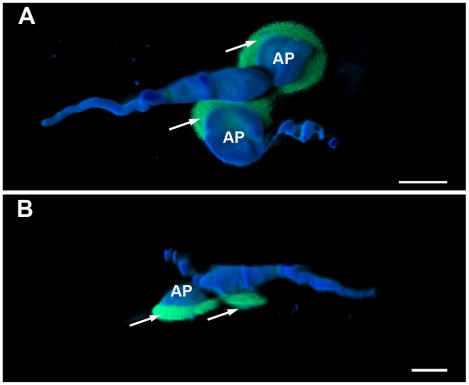
The ROS observed after inoculation with Δhyr1
conidia as a disk-shaped halo located beneath appressoria.(A) A 3-D projection of confocal images with the ROS stain
H2DCFDA showed a halo (green) of ROS around and beneath
the appressoria (blue; AP), which emanated from two nearby conidia.
(B) A side-view of panel A showed that the halo was a
thin layer of ROS located beneath the appressoria. The ROS halo sits
directly between the AP and the plant surface. Scale bar
 = 10 µm.